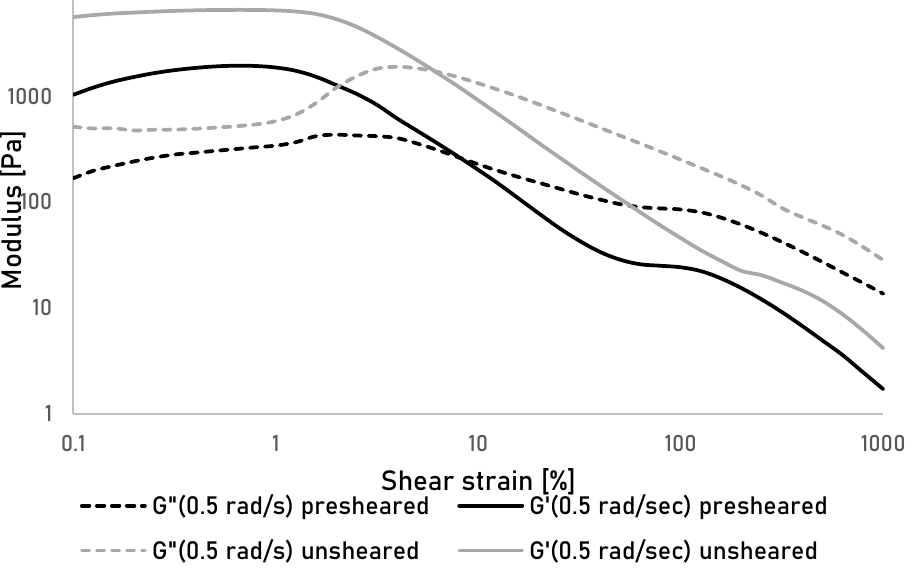
Figure 2. Storage (G’) and Loss (G") modulus of unsheared and presheared cellulose gels measured over shear strain at an angular frequency of 0.5 rad/sec.